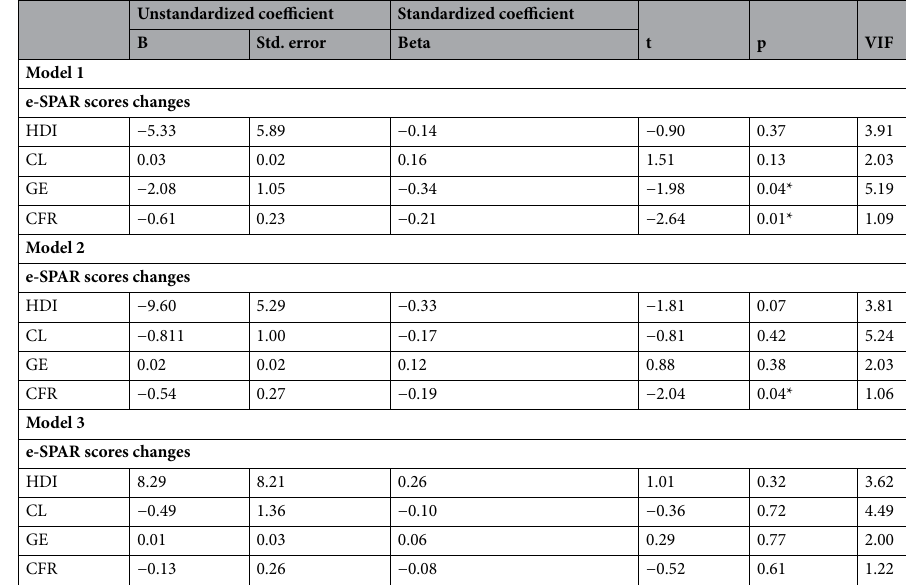
Table 2. The multiple regression analysis results for group A (Model 1), group B (Model 2), and group C (Model 3). From the table, it can be seen that Models 1 and 2 were able to significantly describe the changes in e-SPAR scores among 154 countries (constant = 5.55, F = 5.21, p < 0.01, R 2 = 0.14, adjusted R 2 = 0.12) and among 98 countries whose scores increased (constant = 12.08, F = 5.91, p < 0.01, R 2 = 0.20, adjusted R 2 = 0.17), while Model 3 was not (constant = −9.33, F = 0.84, p < 0.05, R 2 = 0.06, Adjusted R 2 = 0.01). In Model 1, of the four variables, the CFR of COVID-19 (p < 0.05) and GE (p < 0.05) were the factors that were significantly associated with the changes in e-SPAR scores during the pandemic in 154 countries. Meanwhile, in Model 2, the CFR of COVID-19 (p < 0.05) was the only variable that was significantly associated with the changes in e-SPAR scores during the pandemic among countries whose scores